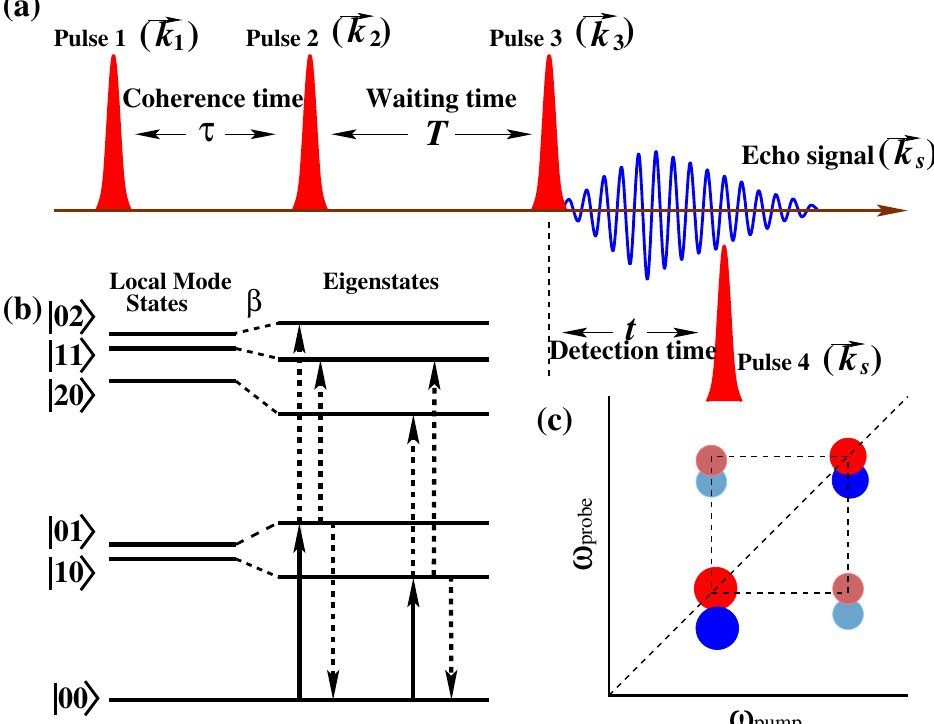
Figure 4. ( a ) Pulse sequence of the photon echo experiment. ( b ) Schematic diagram of two coupled oscillators. Before coupling, vibrational states are depicted as “local modes” and after coupling as “eigenstates”. Vibrational transitions involved in 2DIR spectroscopy of the pair oscillators are depicted by arrows where solid arrows represent the pump processes and probes are represented by dotted arrows. ( c ) The schematic of 2DIR spectral features. The red and blue peaks represent signals with opposite